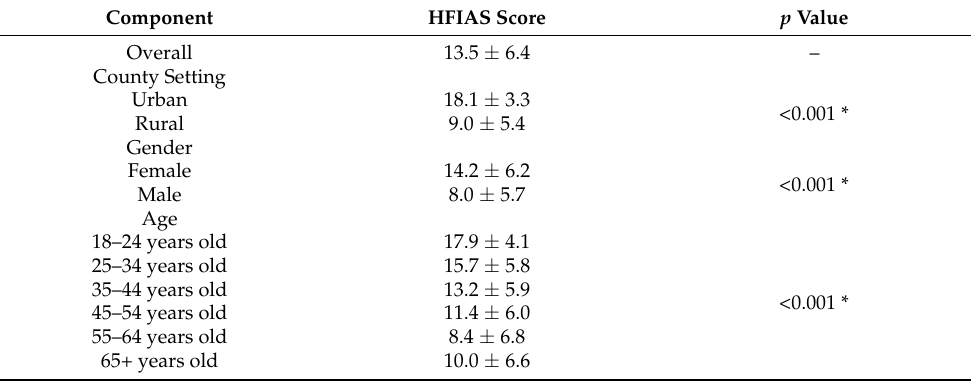
Table 5. Household Food Insecurity Access Scale score by setting and socio-demographic characteris- tics in